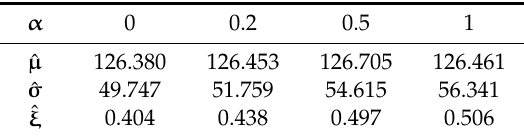
Table 4. MDPDE for the GEV distribution according to α .